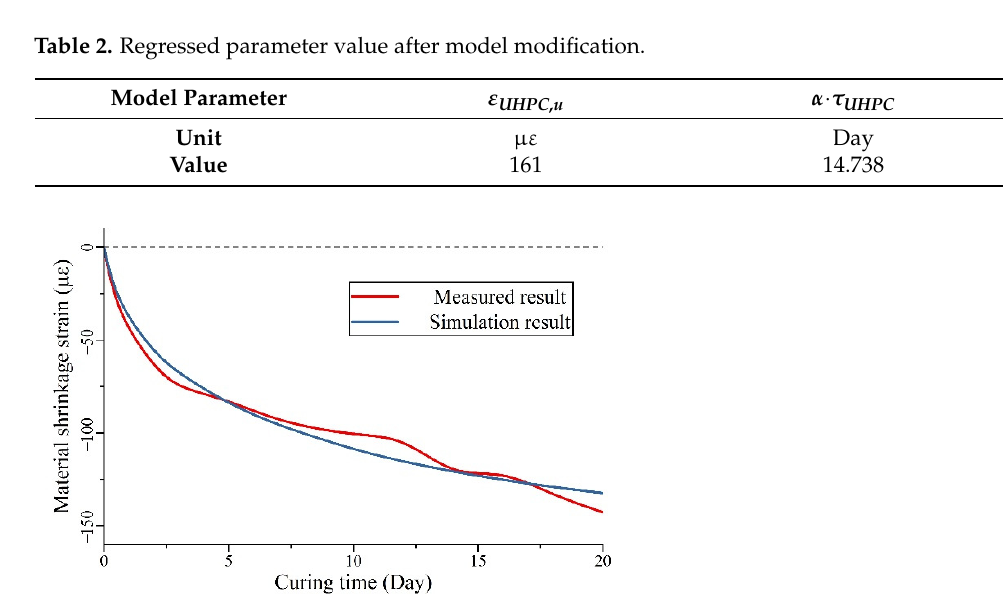
Figure 7. Comparison of measured shrinkage strain and simulation result. Table 3. Prediction error of numerical model compared with measured results.